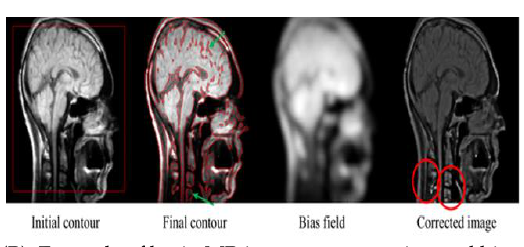
approach; illustration reproduced with the permission of the authors [109].